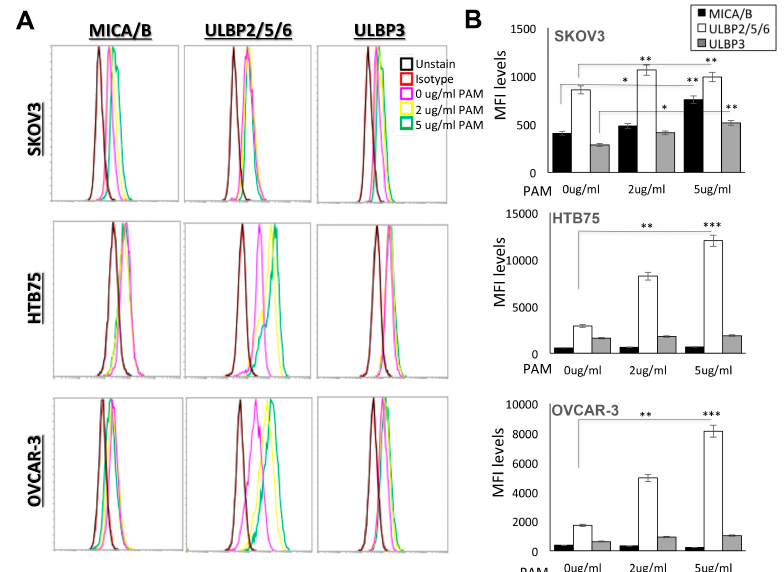
Figure 3. Cell surface expression of NKG2D ligands with and without PAM treatment on tumor cells. ( A ) The indicated tumor cells, SKOV3, HTB75, and OVCAR3, were treated with 2 μ g/mL (yellow) and 5 μ g/mL (green) PAM for 24 h, and stained with MICA/B, ULBP2/5/6, ULBP3 mAbs or control-Ig (red). Analyses were measured on an Acoustic Focusing flow cytometer using the CellQuest software. ( B ) Fluorescence intensity is shown on a log scale on the X-axis. The numbers indicate median fluorescence intensity (MFI) as an increase in relation to the staining with a control-Ig. Data are presented as the mean ± SD of three independent experiments (* p < 0.05; ** p < 0.01; *** p < 0.001). Int. J. Mol. Sci. 2019 , 20 , x FOR PEER REVIEW